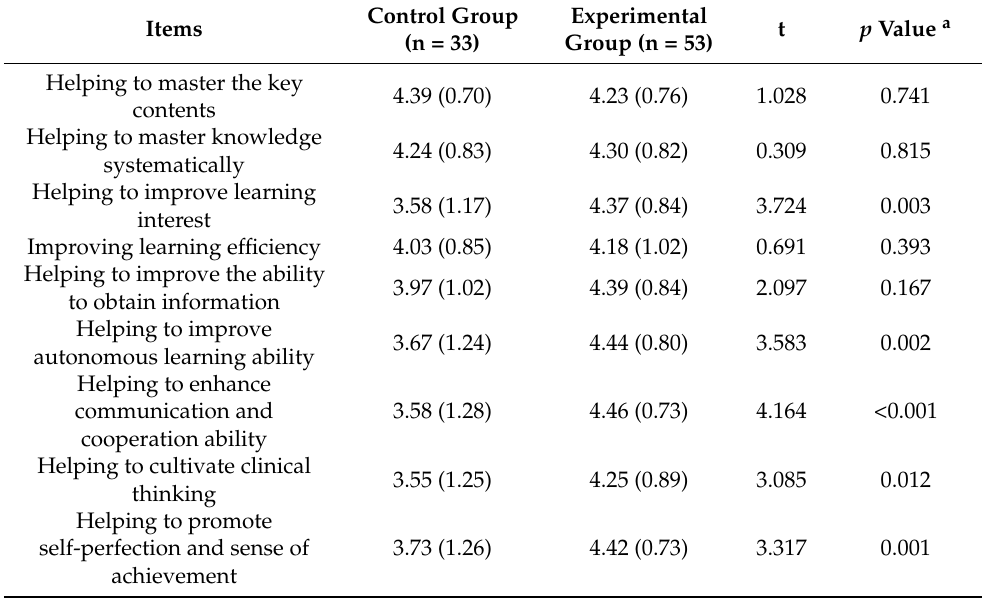
Table 2. Comparison of students’ recognition evaluation of the teaching model between two groups.